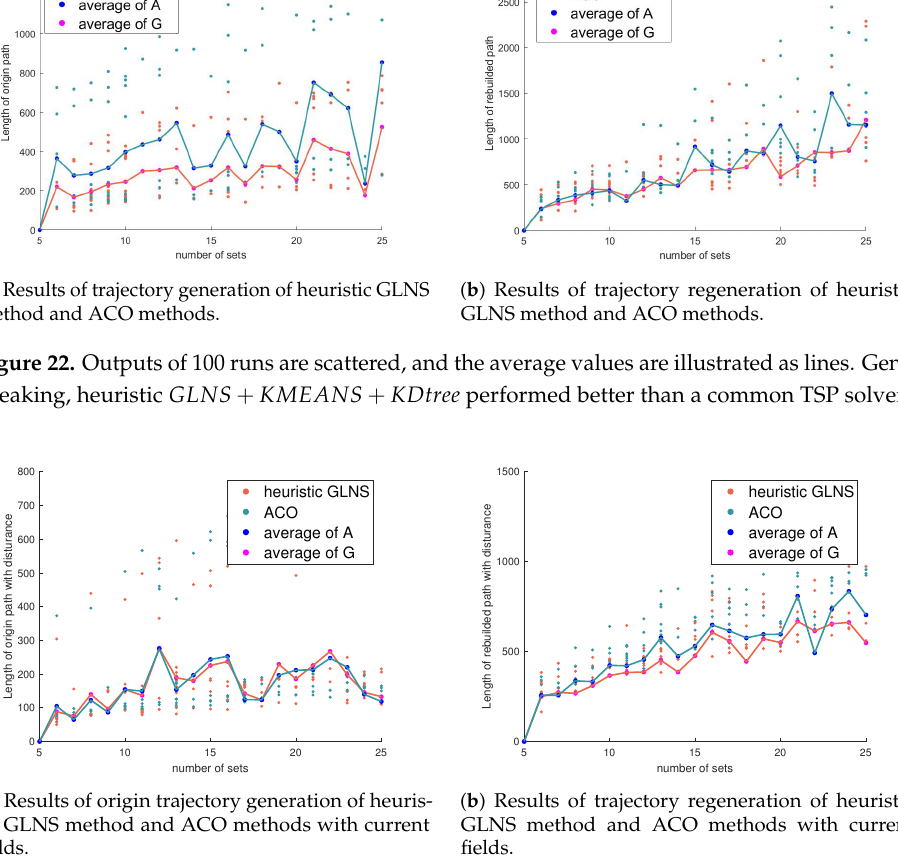
fields. Figure 23. Outputs of 100 runs are scattered, and the average values are illustrated as lines. Gener- ally speaking, with current fields, heuristic GLNS + KMEANS + KDtree performed better than a common TSP solver. The total weighted cost changeed slightly with currents. The average velocity of current was 0.26 m/s underwater, and it was 0.97 m/s in the